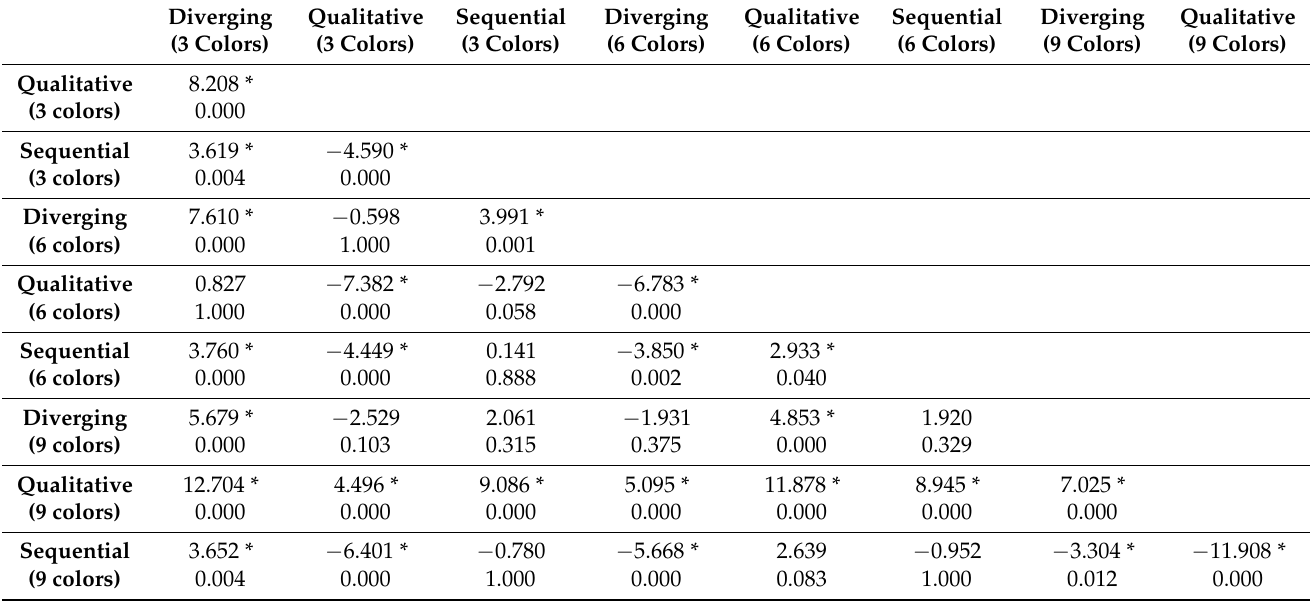
Table 9. The results of the post hoc test for interaction of color scheme group and the number of colors. The first number in each cell is the value of Z and the second number is the respective p